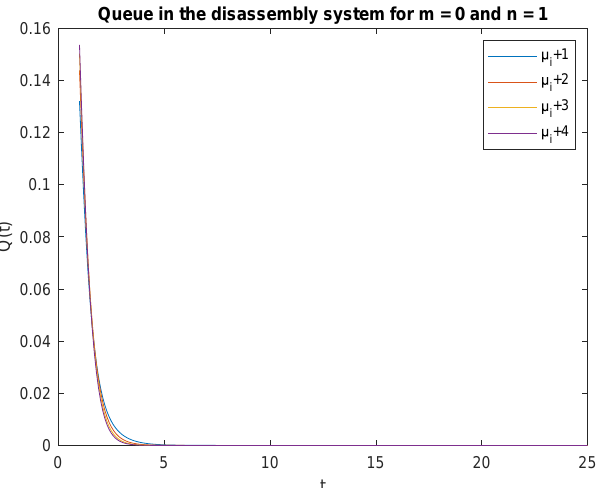
Figure 12. Impact of disassembly rate on probability P { X ( t ) = m = 0 | X ( 0 ) = n = 0 } for λ = 4.